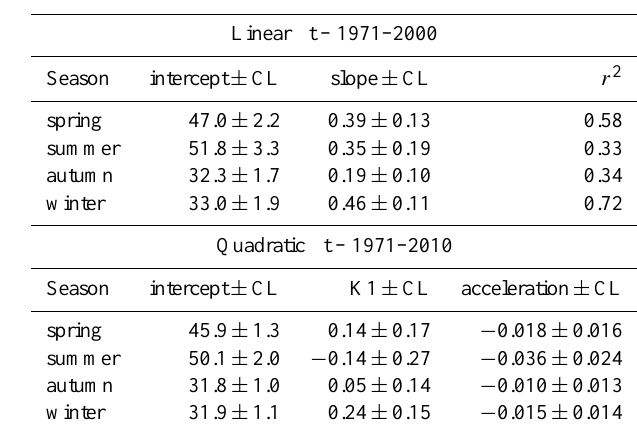
Table 2. Parameters of linear regression using least-squares fits to the Hohenpeissenberg data set. CL indicates the 95% confidence limits of the respective parameters, and r is linear correlation